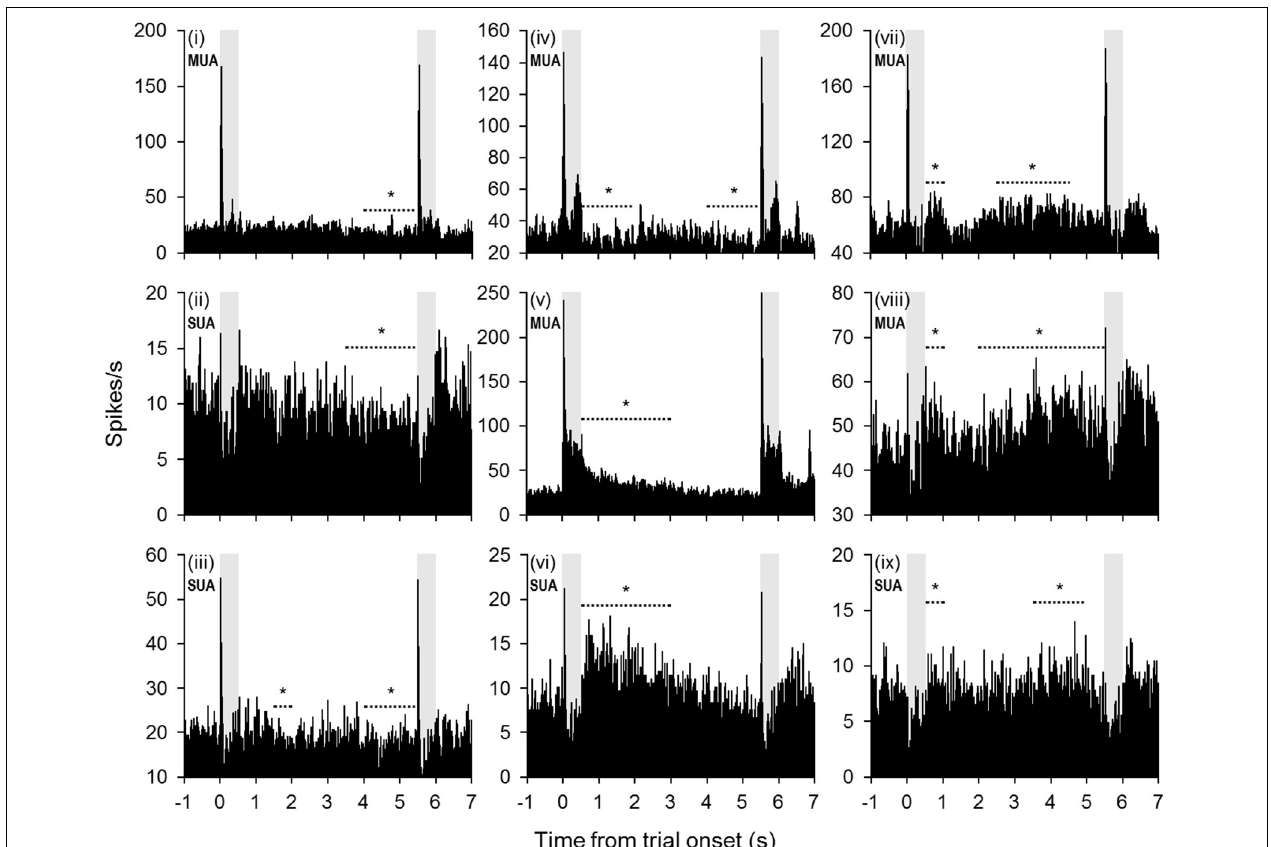
FIGURE 2 | Example units with significant changes in firing rate during the retention interval. Many units exhibited a diminishing firing rate throughout the retention interval (units i–vi). In some cases (units i–iv), the firing rate fell below baseline during the latter portion of the retention interval. In other cases (units v–vi), the firing rate returned to baseline levels from a significantly elevated firing rate earlier in the